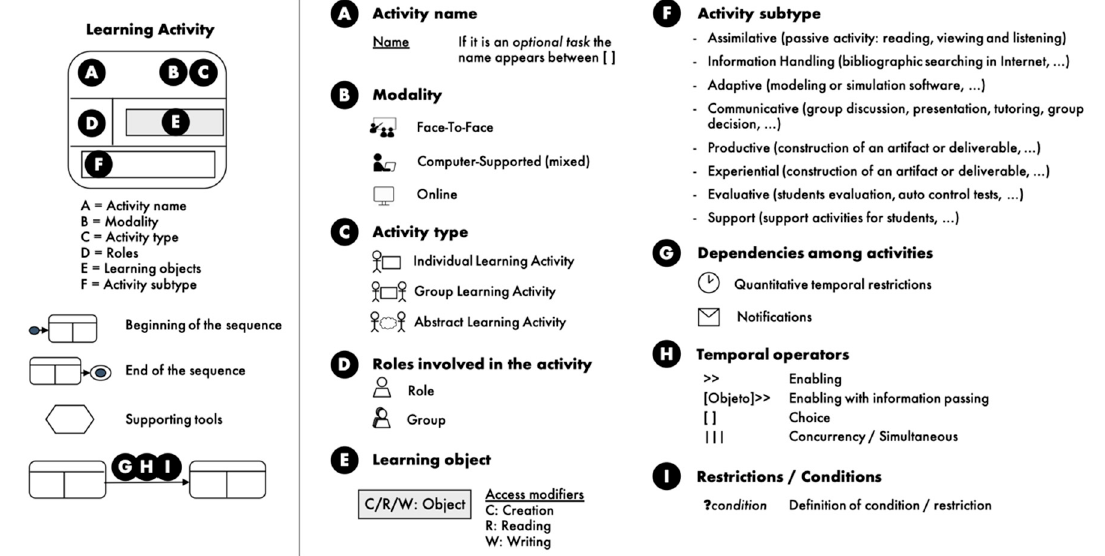
Figure 1. Learn-CIAN